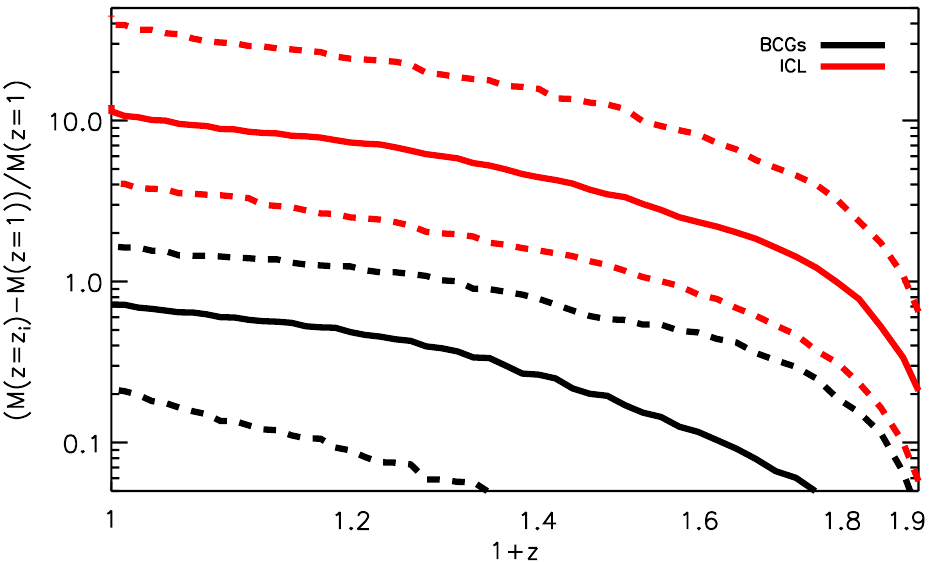
Figure 11. Residual mass of the ICL (red lines) and BCGs (black lines) normalized by the mass at redshift z = 1. Solid and dashed lines represent the median, 16th and 84th percentiles of the distributions, respectively. Credit: Contini et al.